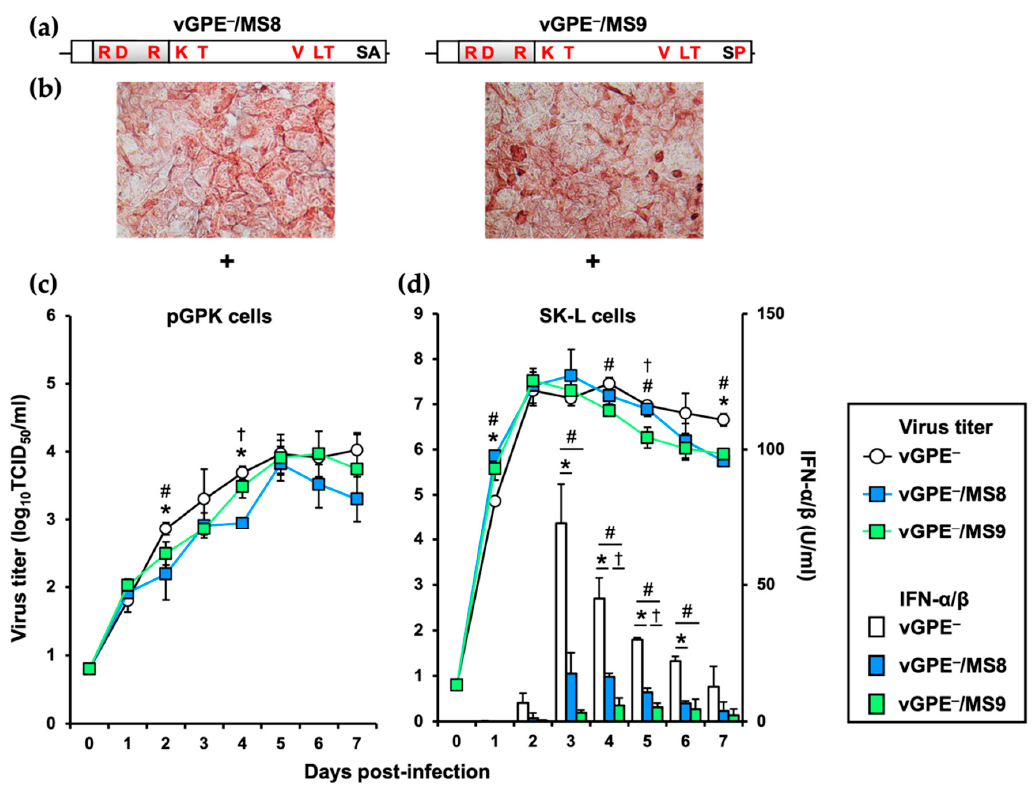
Figure 5. Characteristics of vGPE − , vGPE − /MS8, and vGPE − /MS9 in vitro: ( a ) the viral genomes of vGPE − /MS8 and vGPE − /MS9 are shown; ( b ) the in vitro-transcribed RNAs of vGPE − /MS8 and vGPE − /MS9 were electroporated into the SK-L cells. After 72 h, the cells were heat-fixed and immunostained using the anti-NS3 mAb, 46/1. + depicts that the antibody reacted with the viral NS3 proteins: the success of virus rescue.—depicts that the antibody did not react with the viral NS3: failure of virus rescue. The original magnification was ×200; ( c and d ) the pGPK cells and SK-L cells were infected with vGPE − , vGPE − /MS8, or vGPE − /MS9 at a multiplicity of infection (MOI) of 0.001. The pGPK and SK-L cells were incu- bated at 30 °C and 40 °C in the presence of 5% CO 2 , respectively. The supernatants were collected at indicated times. The titers were measured in SK-L cells and expressed as 50% tissue culture infective dose (TCID 50 ) per mL. The IFN- α / β bioactivity in the supernatants of SK-L cells was measured using the SK6-MxLuc cells. Error bars represent the standard deviations. The significance of mutant viral growth differences was calculated using one-way ANOVA followed by Student’s t -test with Bonferroni correction. * indicates p < 0.025 between vGPE − and vGPE − /MS8. # indicates p < 0.025 between vGPE − and vGPE − /MS9. † indicates p < 0.025 between vGPE − /MS8 and vGPE −